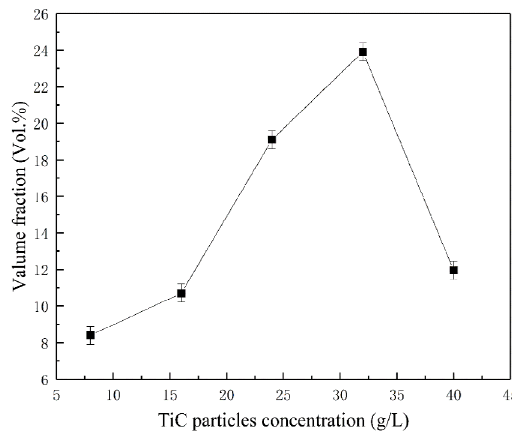
Figure 6. Effects of TiC concentration on the volume fraction of TiC particles in composite Table 2. Mass fraction of Ni and Ti element of composite coatings with different TiC concentration in bath TiC concentration in bath (g/L)